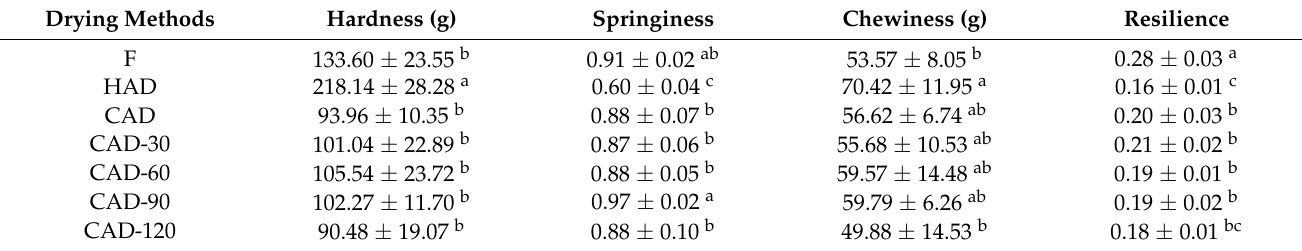
Table 1. Texture characteristics of pufferfish fillets under different drying